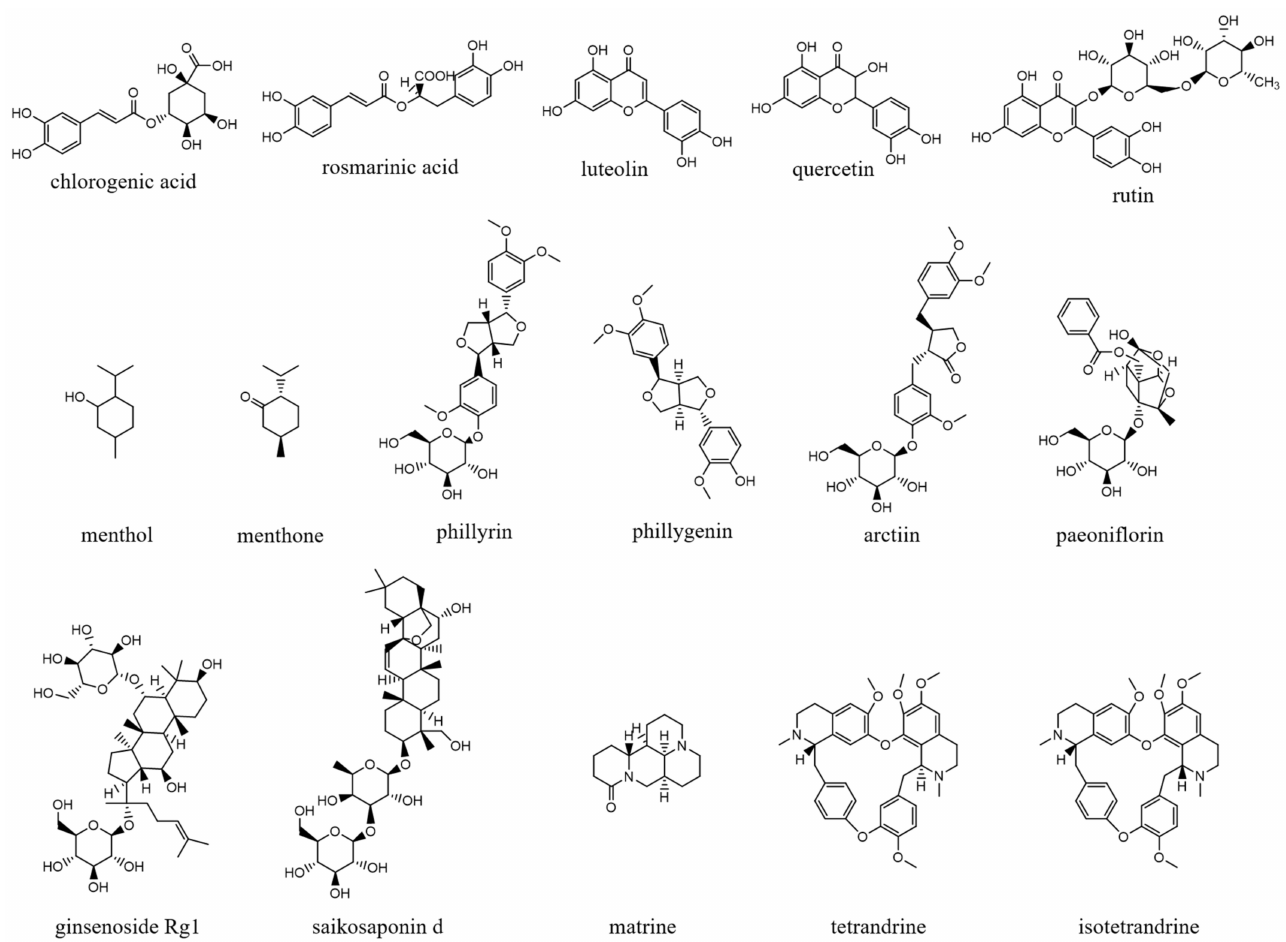
Figure 1. Chemical structures ofthe naturalproducts isolatedfrom TCMswithimmunomodulatory